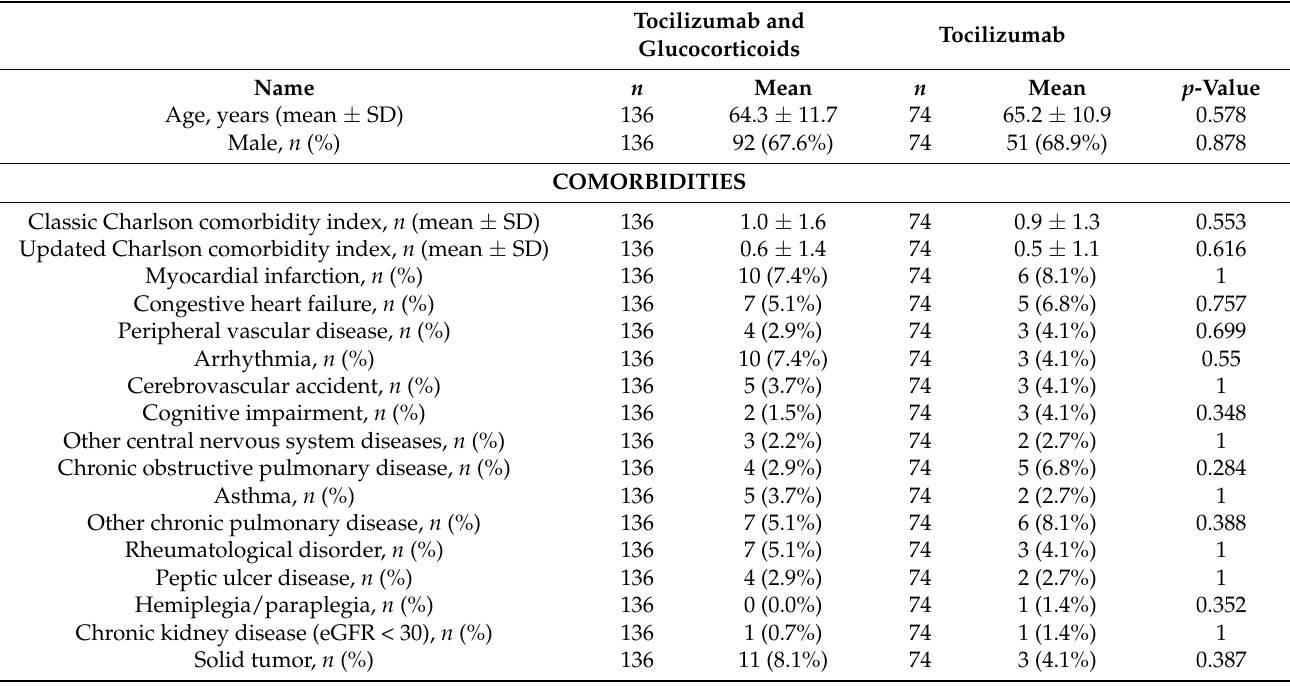
Table 1. Admission characteristics of patients by treatment